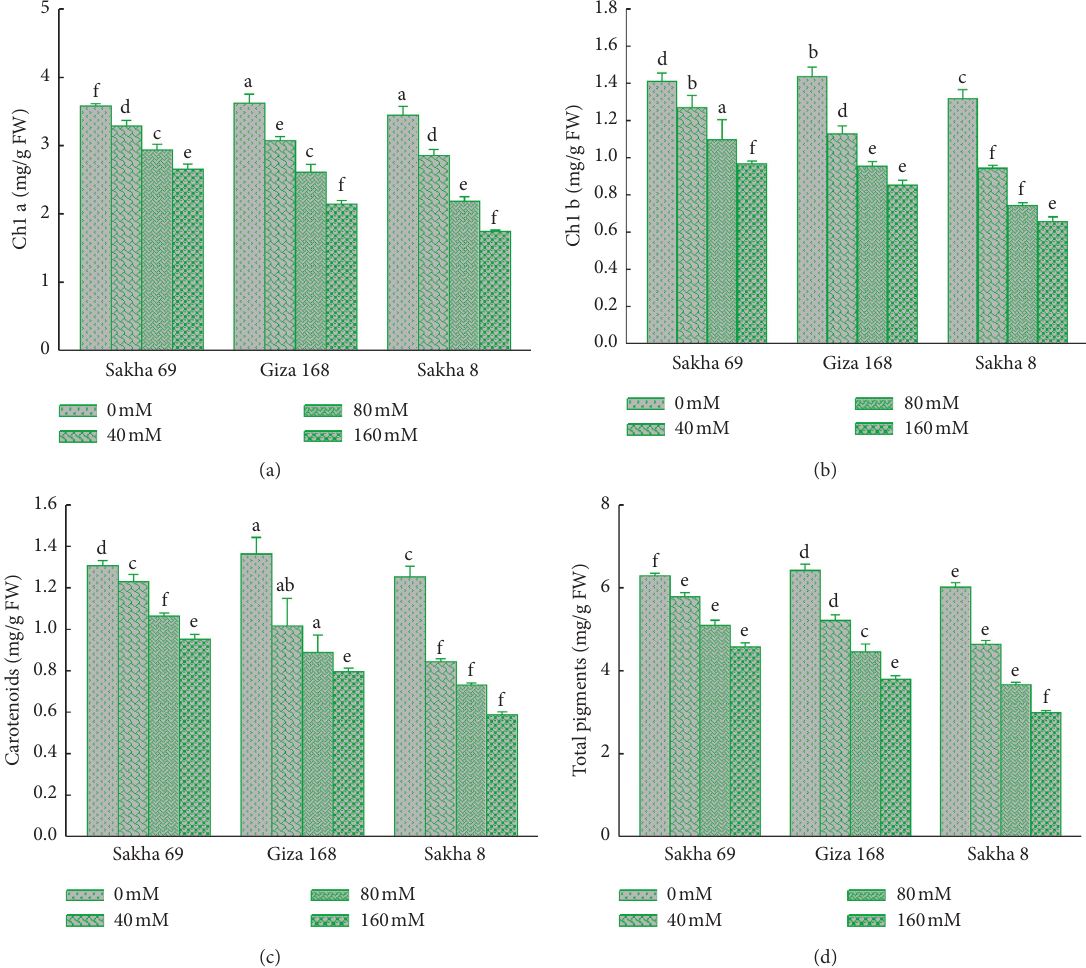
Figure 2: The impact of salt stress (0, 40, 80, 160mM) on the photosynthetic pigments in flag leaf of wheat cultivars: (a) Chl a; (b) Chl b; (c) carotenoids; and (d) total pigments. Each column symbolizes mean ± SE ( n � 3). Means and standard errors are demonstrated by error bars. Letters point out significant differences at p < 0 .